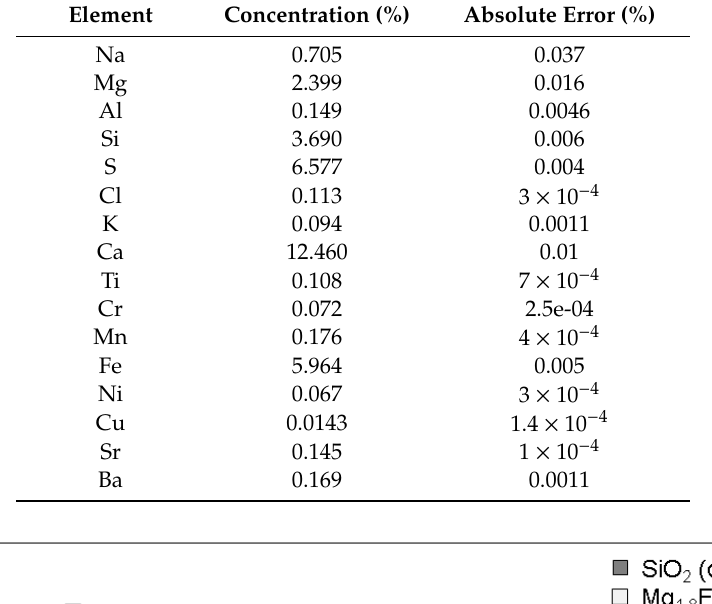
Table 4. XRF analysis of lignite ash produced during the gasification test.